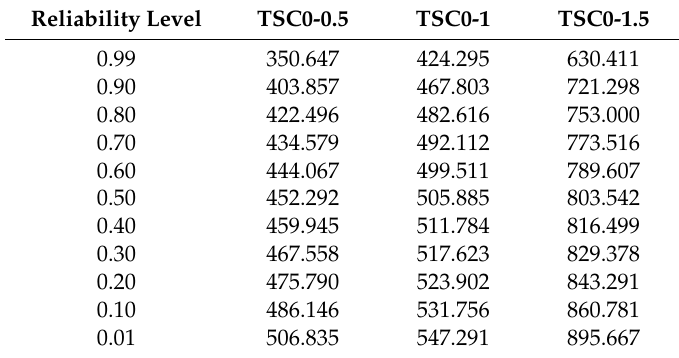
Table 4. Weibull distribution for impact energy of recycled tire steel wire reinforced TSC specimens.